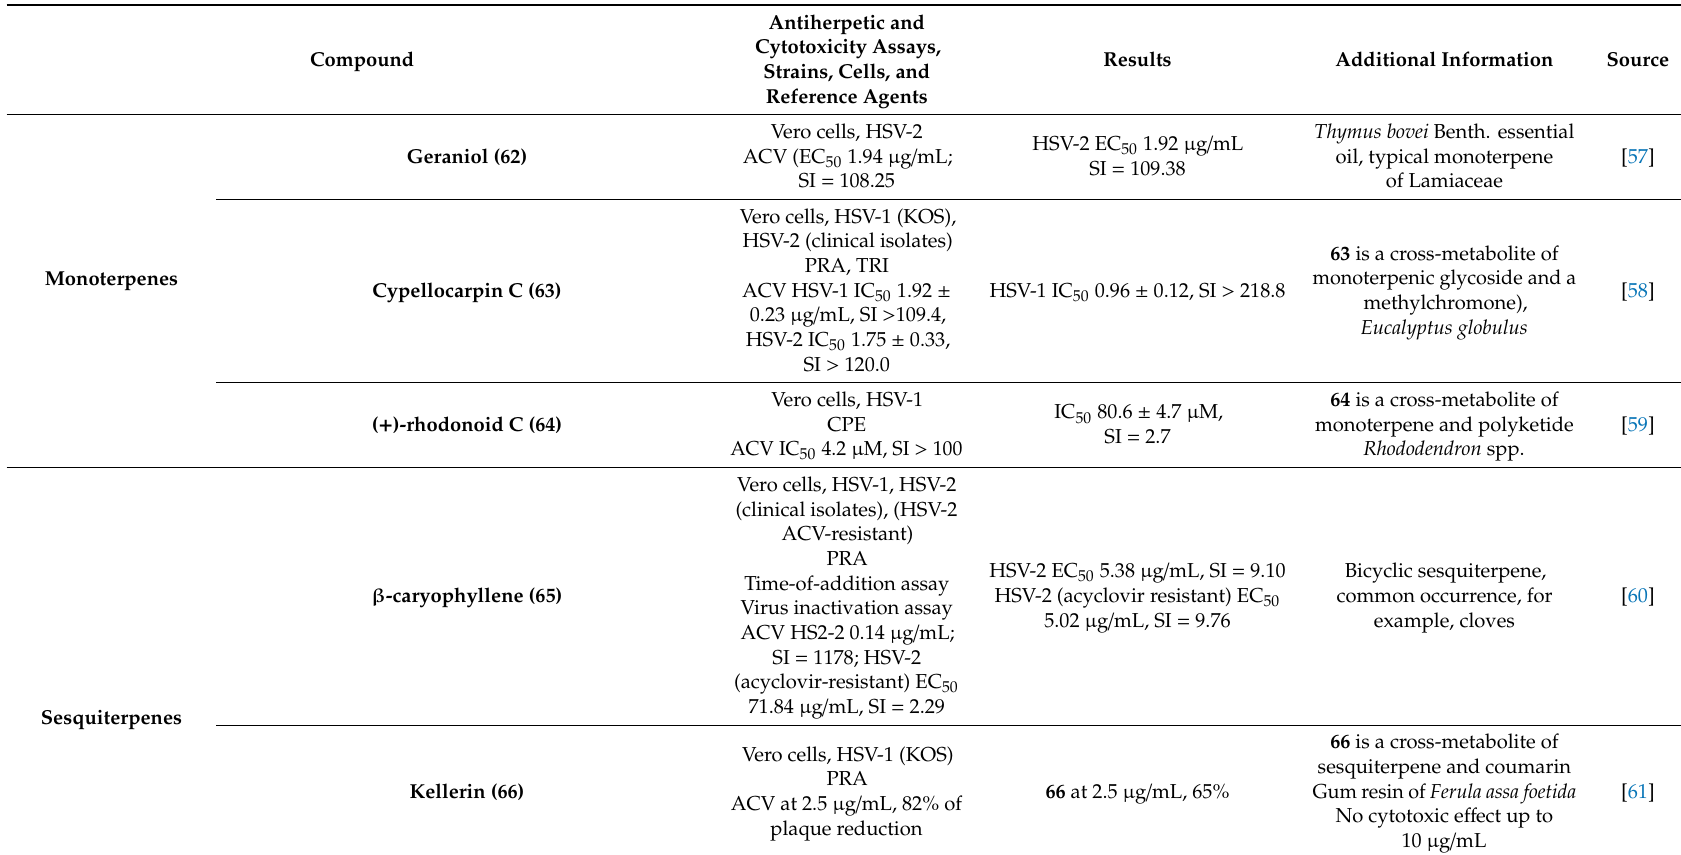
Table 3. The overview of terpenoid compounds with anti-HSV